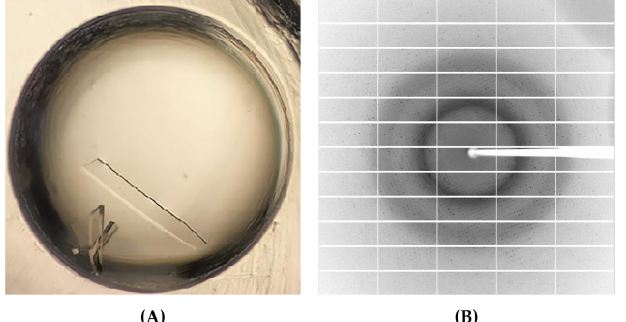
Figure 4. Crystallization and X-ray diffraction of PaAst. ( A ) Crystals observed in 0.2 M sodium thiocyamate, 20% PEG3350. ( B ) Representative diffraction pattern. Each asymmetric unit contained two chains of PaAst sharing RMSD of 0.18 Å over Cα, and the chains formed a dimer with extensive contacts (Figure 5A). According to the calculation of the PDBe PISA Server (https://www.ebi.cu.uk/msd-srv/prot_int/cgi- bin/piserver, accessed on 19 September 2022), the dimer interface had a buried solvent accessible area of 2245.3 Å 2 , which accounted for 16.5% of the total solvent accessible area. Therefore, the dimerization could be observed both in solution, proved by size-exclusion chromatography, and in the crystal structure.